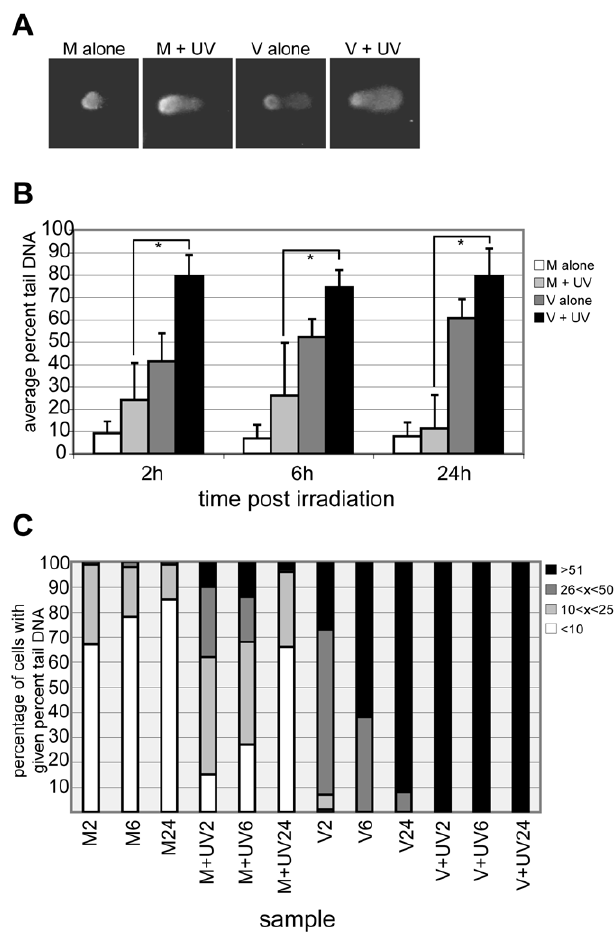
Figure 2. Comet analysis revealed NER repair was initiated in virus-infected cells. HFFs were mock- or virus-infected at an MOI of 5 and irradiated at 48 hpi at a dose of 50 J/m 2 or left unirradiated. At 2,6 and 24 h p irradiation, cells were harvested for comet analysis. A) Examples from each sample group are shown at 2 hp irradiation. B) Using VisComet, 50–100 cells/sample were analyzed for M alone (white bars), M + UV (light grey bars), V alone (dark grey bars) and V + UV (black bars) samples (except for V + UV 2 h, which had 37 cells analyzed). Comets were analyzed for % DNA in the tail and bars represent the average of all cells within a given sample population. Error bars represent one SD from the average. An * denotes a statistical significance of p , 0.0001 between samples as measured by unpaired t-test. C) Each sample set represented by an average in (B) was further analyzed for distribution of individual cells in that sample set within four categories of % tail DNA. Those categories were , 10% tail DNA (white bars), 11–25% tail DNA (light grey bars), 26–50% tail DNA (dark grey bars) or . 50% tail DNA (black bars). The number of comets in each category was then converted to a fraction of 100% and plotted.